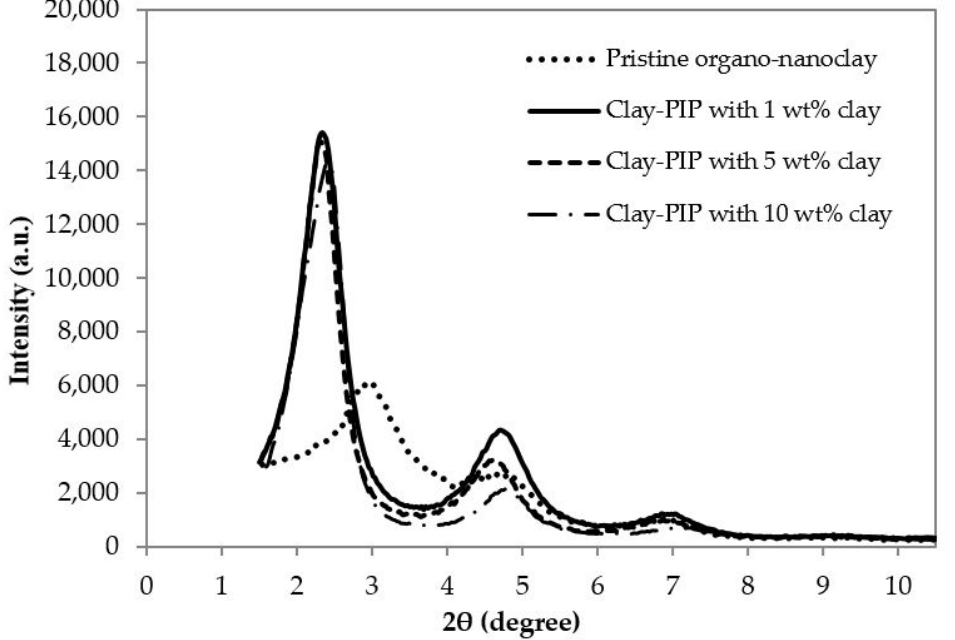
Figure 5. XRD patterns of pristine organo-nanoclay and solid composites based on the Clay-PIP latexes with varied amounts of